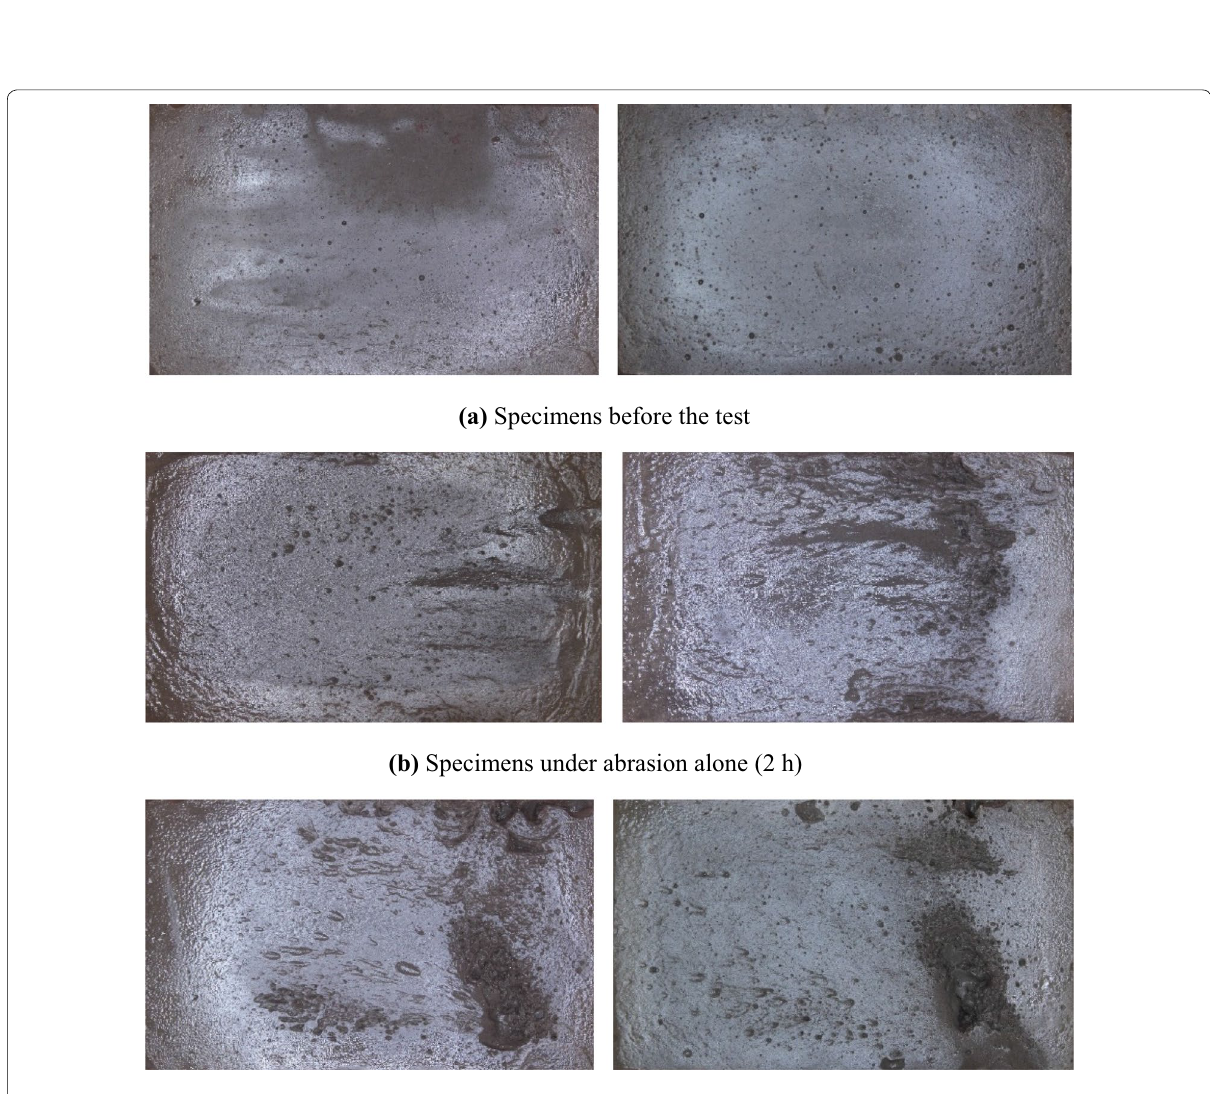
Fig. 10 Morphology of cement specimen surface before and after the